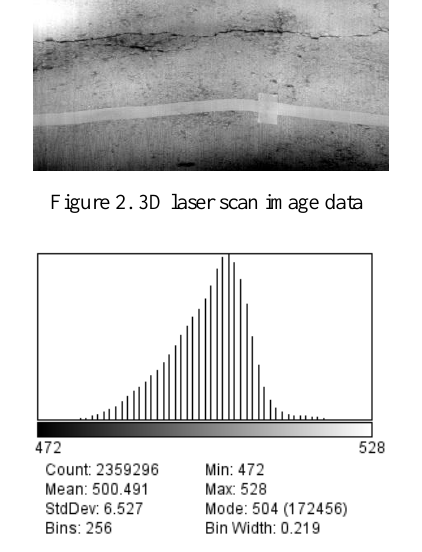
Figure 3. Histogram of 3D laser scanned image data